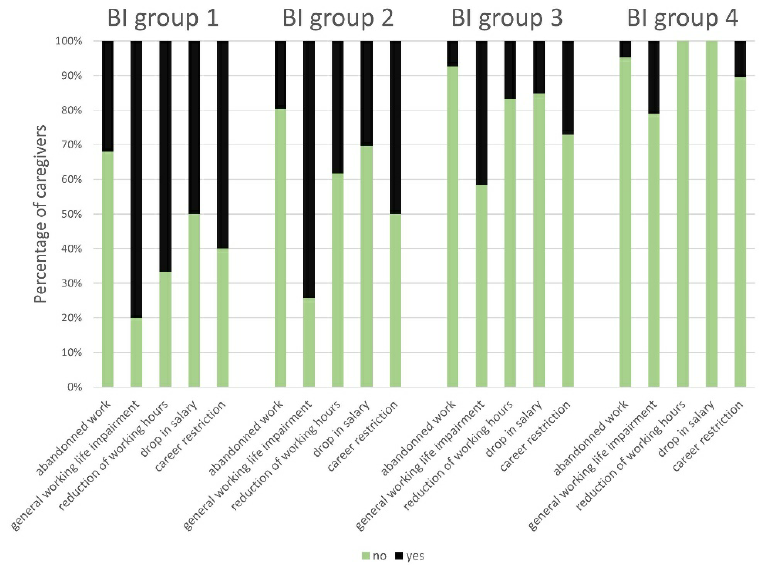
Figure 5. Impairment in caregivers’ work lives according to BI groups: The caregivers were able to state their work life impairment with “yes/no” in the following domains: abandoned work due to caregiving; general work life impairment; reduction of working hours; drop in salary; career restriction. Five adjacent columns are assigned to each BI group. One column corresponds to one domain. The extent of the colored sections represents the percentage of caregivers. There was a statistically significant correlation of the investigated domains to the BI groups. Abbreviations: BI = Barthel Index.